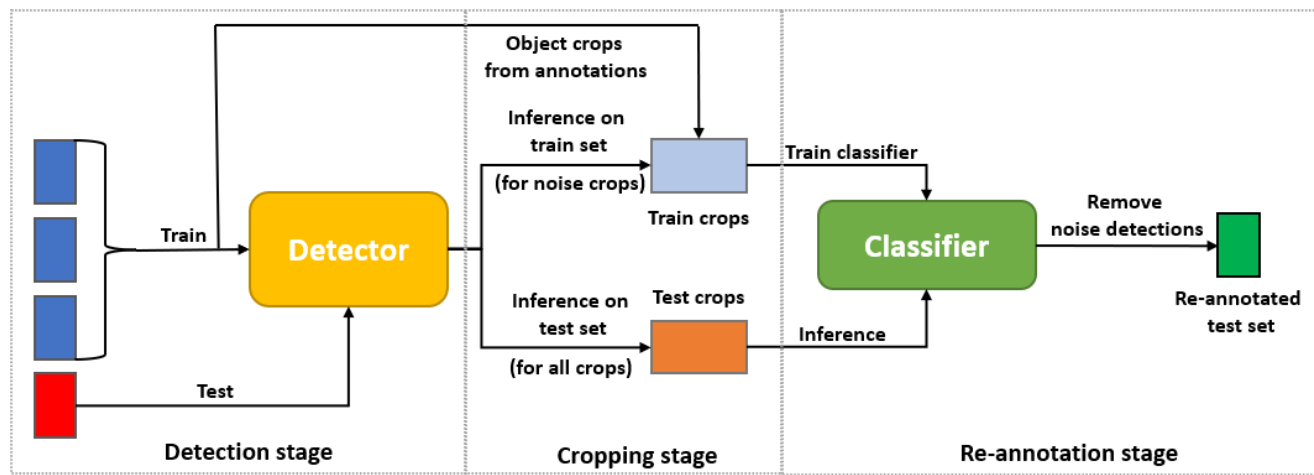
Figure 2. An overview of our re-annotation model. It consists of 3 stages: the detection stage, in which the object detection model is trained and the objects of interest are detected on the validation set; the cropping stage, in which crops for the classifier are extracted based on the detections from the previous stage; the re-annotations stage in which the classifier is trained on the extracted crops of the objects of interest from the train set, as well as noise, and then used to detect which objects found in the detection stage are valid. In the last stage, the valid detected objects are also saved to be used in the next re-annotation